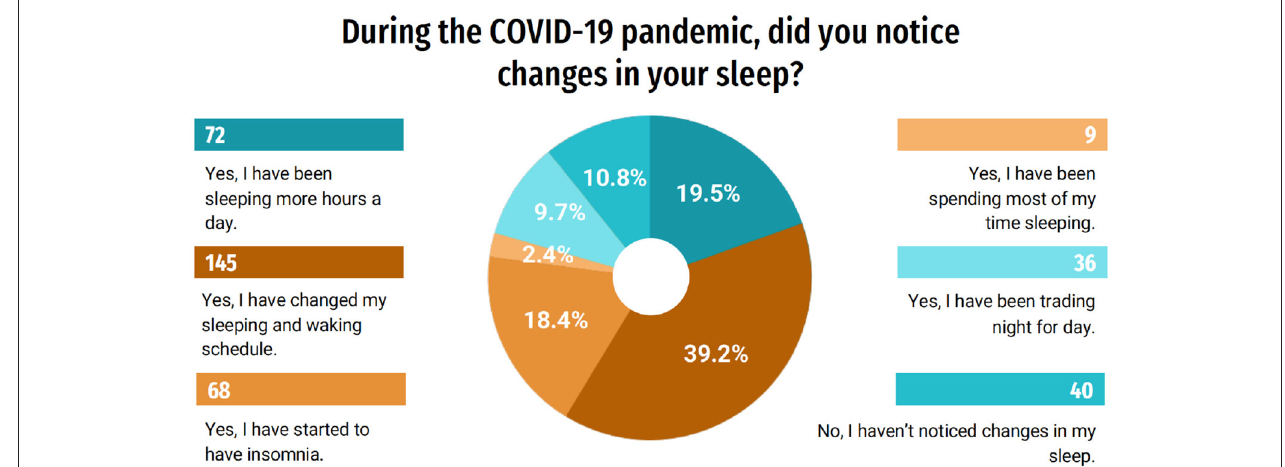
FIGURE 5 | Changes in sleep routine.